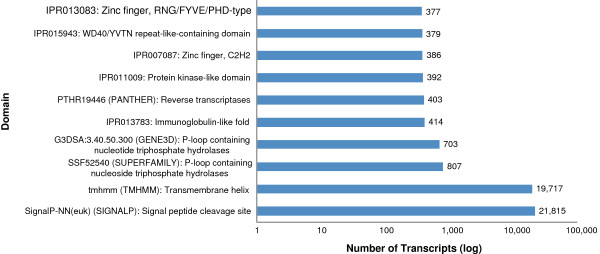
InterPro annotations. Top 10 represented InterPro terms from the InterProScan annotations.